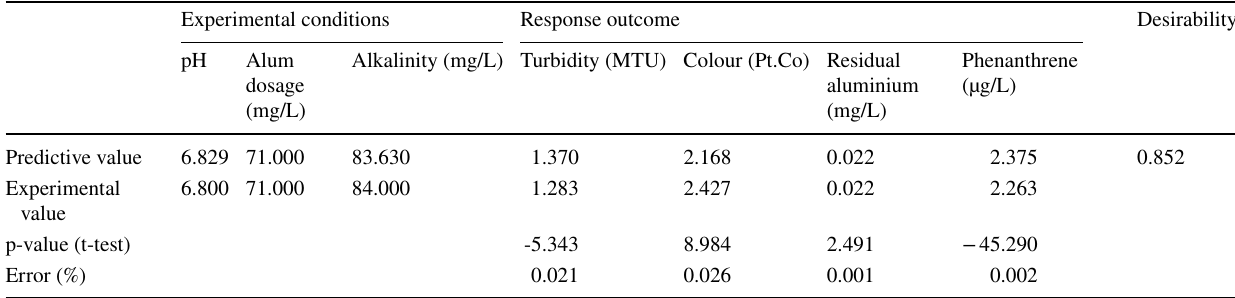
Table 9 Desirable equation model calibration with experimental pilot trial Experimental